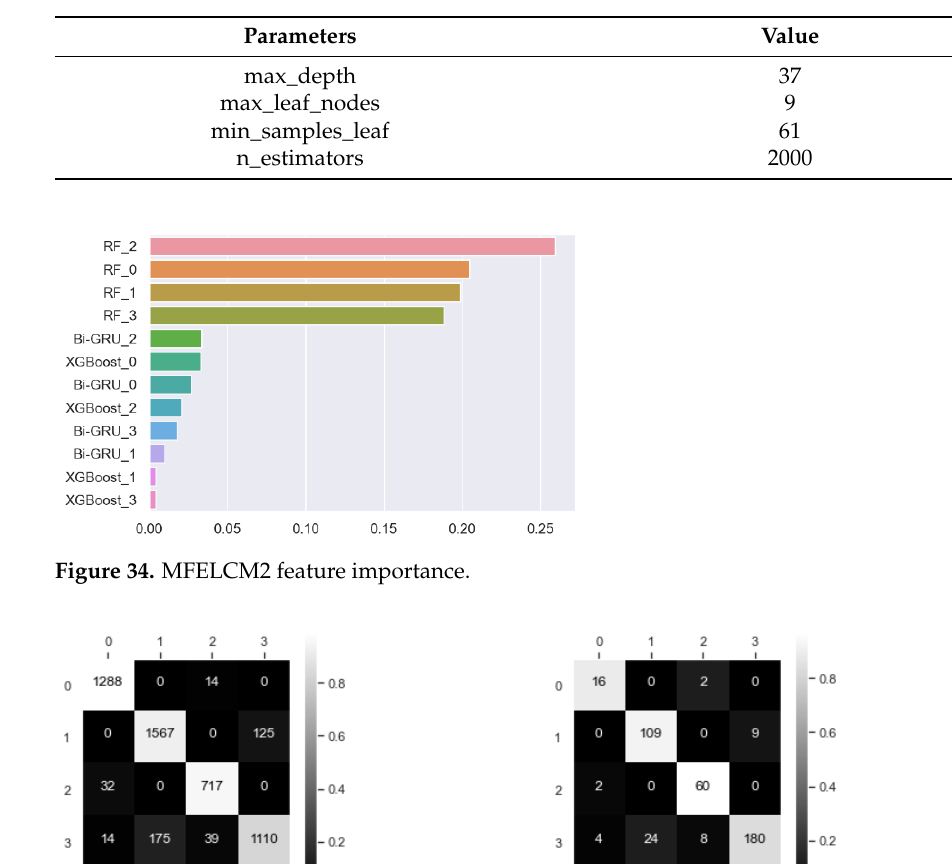
Table 16. Parameters of Random Forest2 (in MFELCM2).